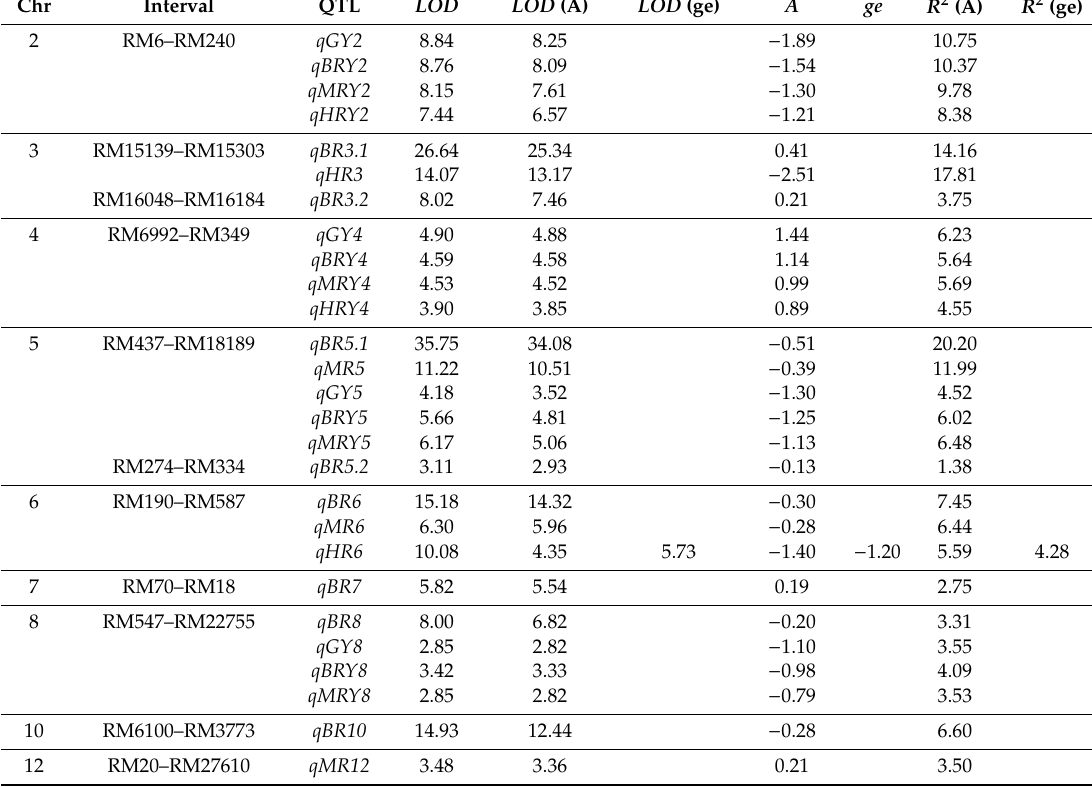
Table 2. QTLs for seven traits detected in the TI population.